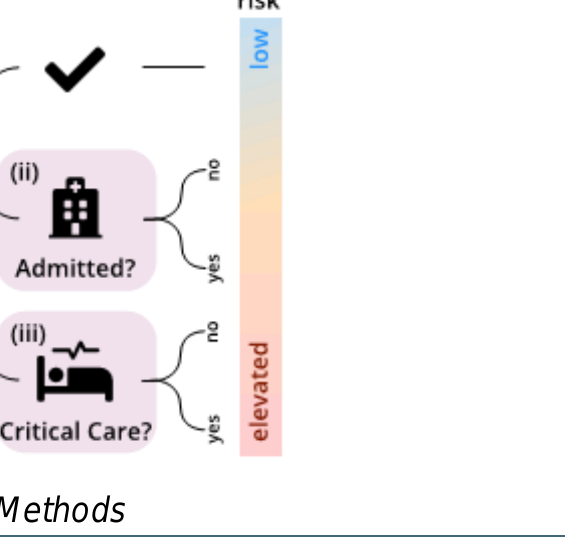
Figure 1. We study the use of predictive models (light purple) to estimate whether patients are likely (i) to be SARS-CoV-2 positive and whether SARS-CoV-2 positive patients are likely (ii) to be admitted to the hospital and (iii) to require critical care based on clinical, demographic, and blood analysis data. Accurate clinical predictive models stratify patients according to individual risk and, in this manner, help prioritize health care resources such as testing, hospital, and critical care